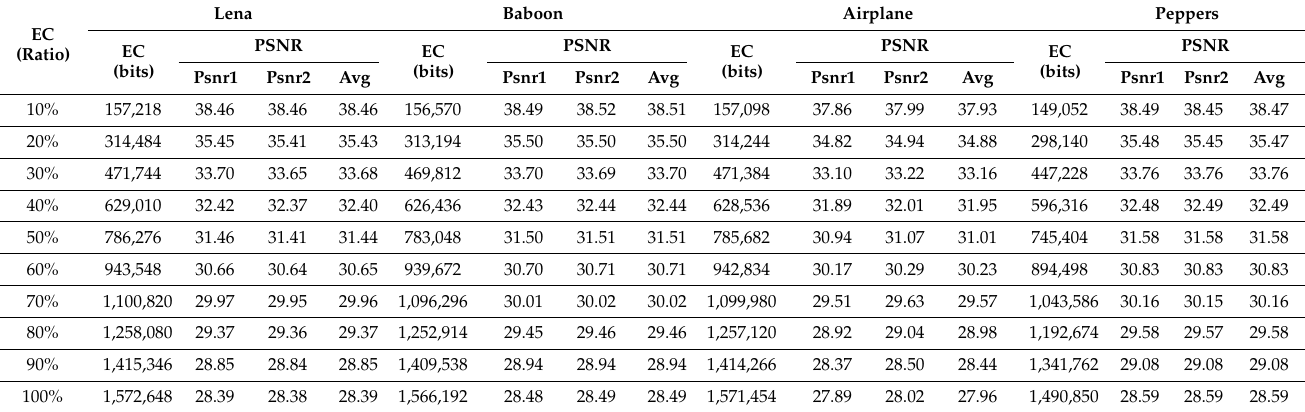
Table 7. Comparison of embedding capacity and PSNR value of different stego images for n = 5.